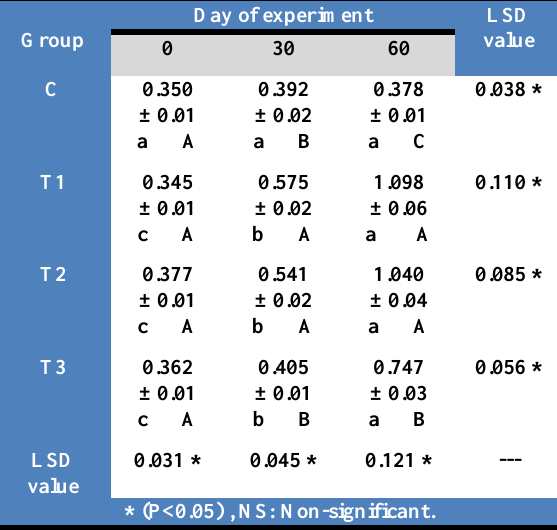
Table, 3: The effect of oral intubation for two months with sodium molybdate, sodium sulfate and their combination on Total Serum Creatinine concentration (mg/dL) of adult male rats. Group